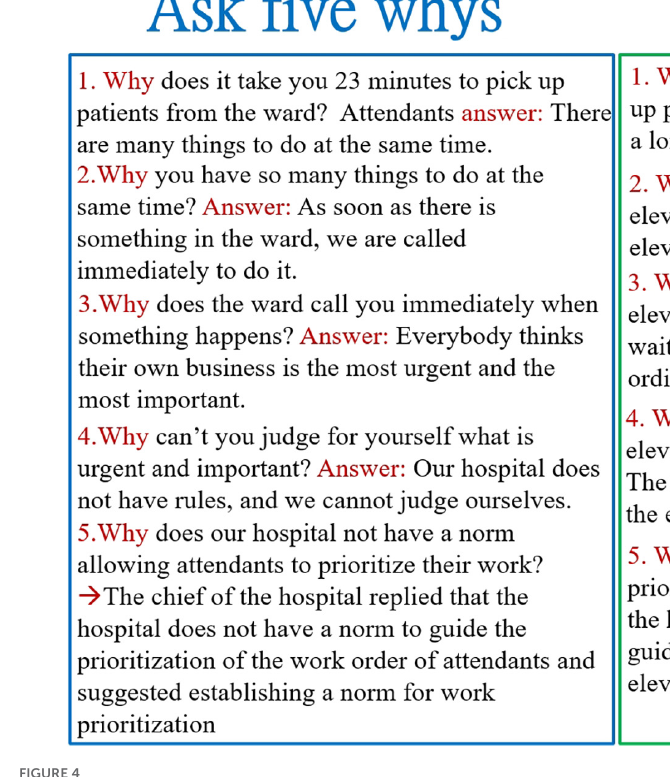
FIGURE4 Five why questions were used to identify the root cause of attendant-related